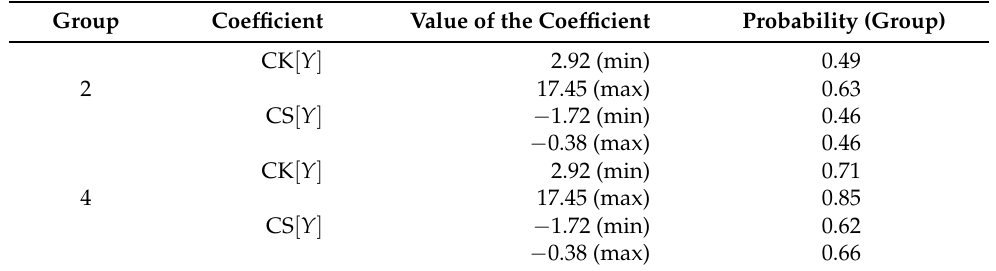
Table 11. Probability of belonging to the groups according to the CS and CK for the simulation study.